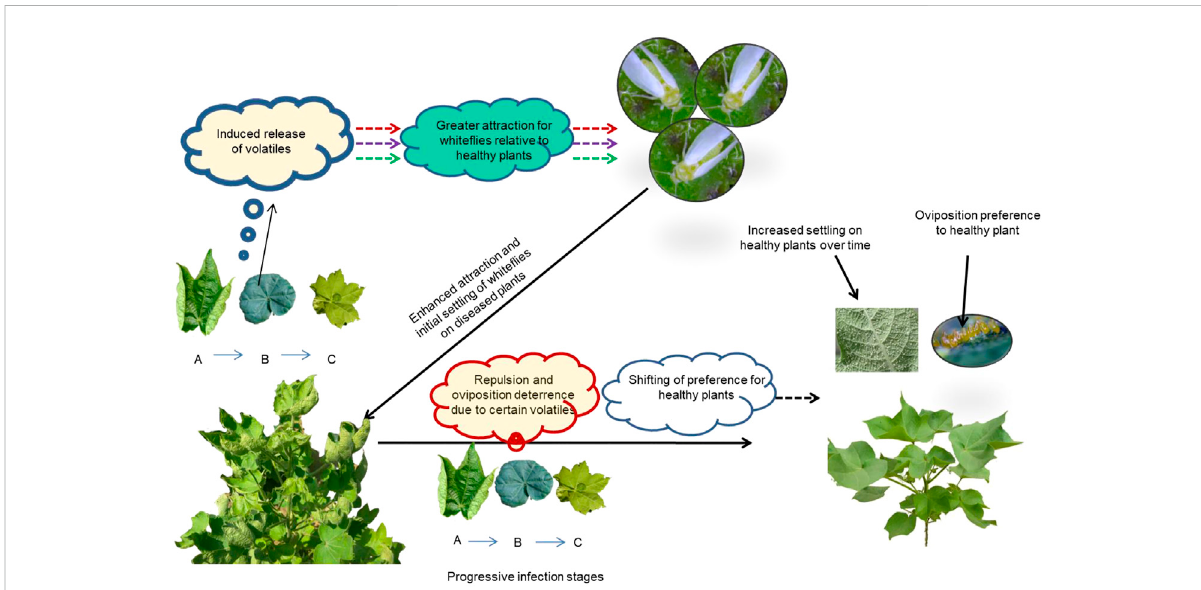
FIGURE 8 Dynamic interactions between Cotton Leaf Curl Virus and its vector, Bemisia tabaci . Although healthy cotton plants are attractive to B. tabaci utilizing a natural blend of volatile organic compounds (VOCs), qualitative and quantitative changes occur in the release of VOCs from CLCuV infection stages with the progression of the disease as shown by symptoms (A) Upward curling, (B) Downward curling and (C) Enation/double leaf. The dynamic changes in the release of certain VOCs from diseased plants exaggerated the attraction cues resulting in higher settling of white fl ies on the diseased plant in the initial phase but over time, white fl ies preferred healthy plants for settling and oviposition, driven by repulsive VOCs from diseased